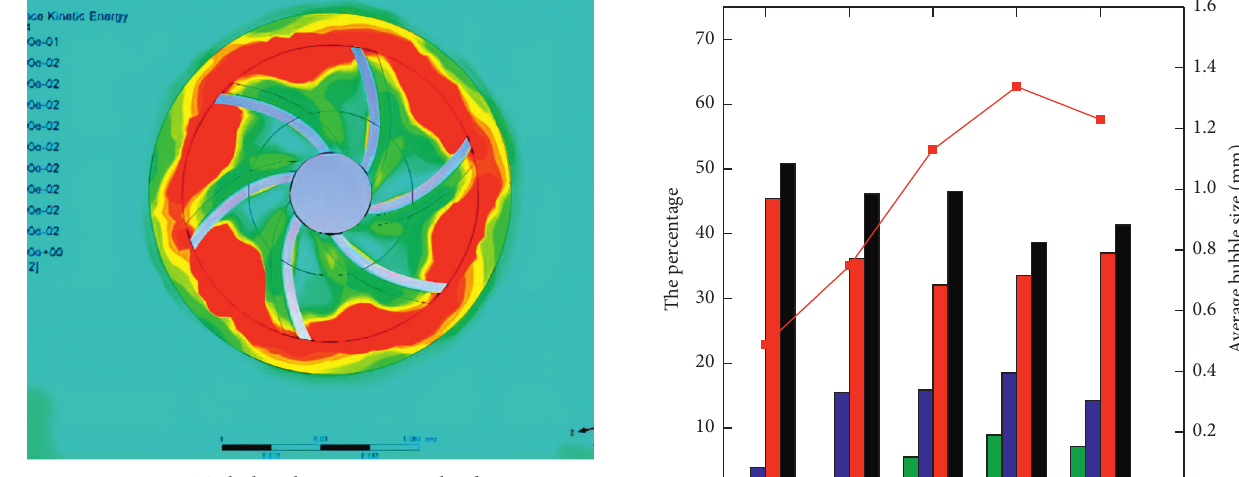
Figure 17: Turbulent kinetic energy cloud map.